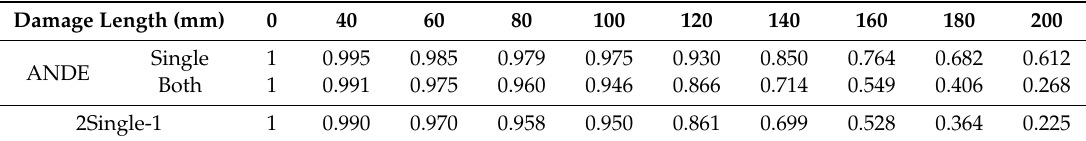
Figure 30. Normalized dissipated energy: ( a ) Single tenon damaged; ( b ) both tenons damaged. Table 4. Averaged normalized dissipated energy (ANDE) of damaged models.